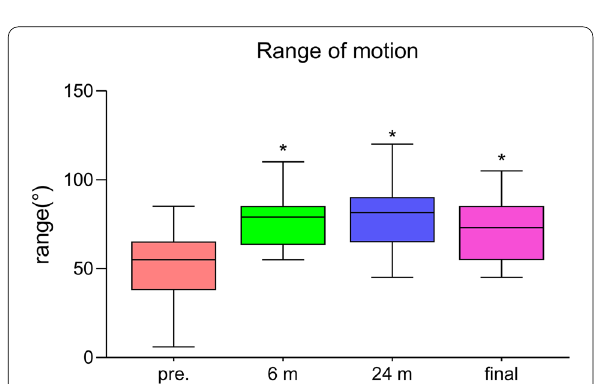
Fig. 3 Trend in the ROM, with the results obtained preoperatively, at 6 and 24 months postoperatively, and at the final follow-up shown. ROM range of motion, Pre . preoperative; * P value < 0.05 versus the